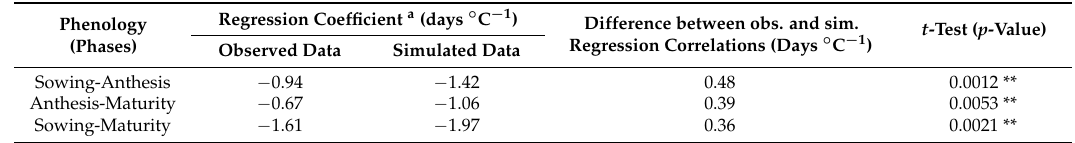
Table 3. Comparison of the responses of cotton phenology with average temperature using the observed and simulated data in Punjab, Pakistan, during